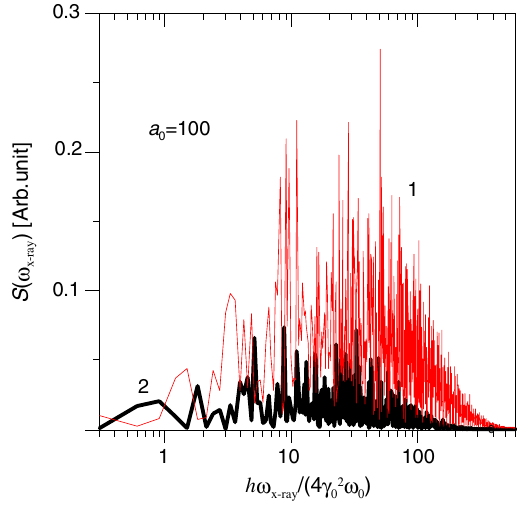
FIG. 8. Spectra of backward scattering ( θ ¼ π ) in the two pulse scheme (1) (red curve) for the time delay 45 fs as in Fig. 7 (2) (both pulses have a 0 ¼ 100 , τ ¼ 10 fs, the scattered pulse is focused to w 0 ¼ 5 μ m, the driving pulse is a plane wave) and with only the scattered pulse (2) (black